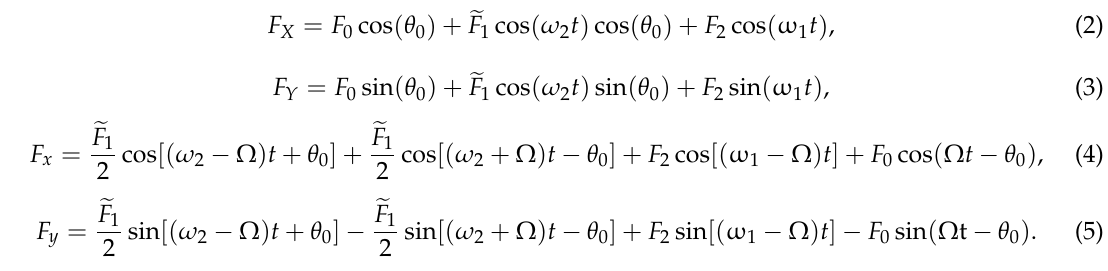
XY 𝐹 1 xy 𝐹 1 𝑡𝐹 2 𝜔 1 Ω𝑡𝜃 0 Figure 5. Schematic of a generic unsteady force acting on the shaft with respect to the rotating frame ( 𝑥𝑦 ) and the fixed one ( 𝑋𝑌 ). 𝐹 1 , force with a fixed direction 𝜃 0 and oscillating amplitude; 𝐹 2 , rotating force with velocity 𝜔 1 ; Ω , rotating frame speed. Figure 6. VAMPUFF total head ( Ψ 𝑇 ) versus flow coefficient ( Φ ) at different rotating speed ( Ω ), T ≅ 20 °C.